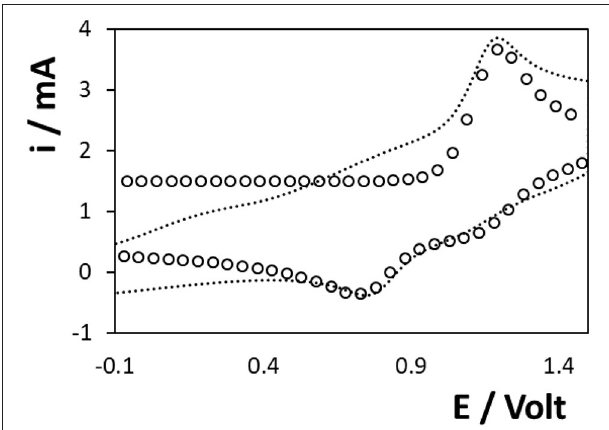
FIGURE 3 | Voltammogram of a 10mM solution of [Ru(bpy) 3 ] 2 + at the 3D Ti electrode. Before recording the CV, the electrode was preconditioned at − 1.0V, where the oxide is reduced, for 60s followed immediately by the voltammetric scan with no quiet time. The supporting electrolyte is aqueous 0.1M H 2 SO 4 . The scan rate is 0.1V s − 1 . The open circles represent the best fit simulated voltammogram in which D is 1.1 × 10 − 5 cm 2 s − 1 and k o is 1.1 × 10 − 4 cm s − 1